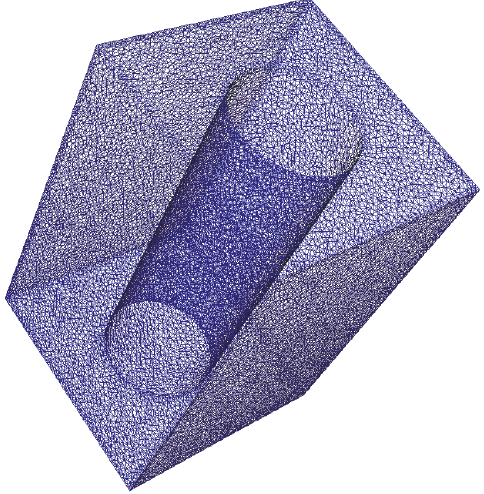
Figure 13: The 3D domain with computational